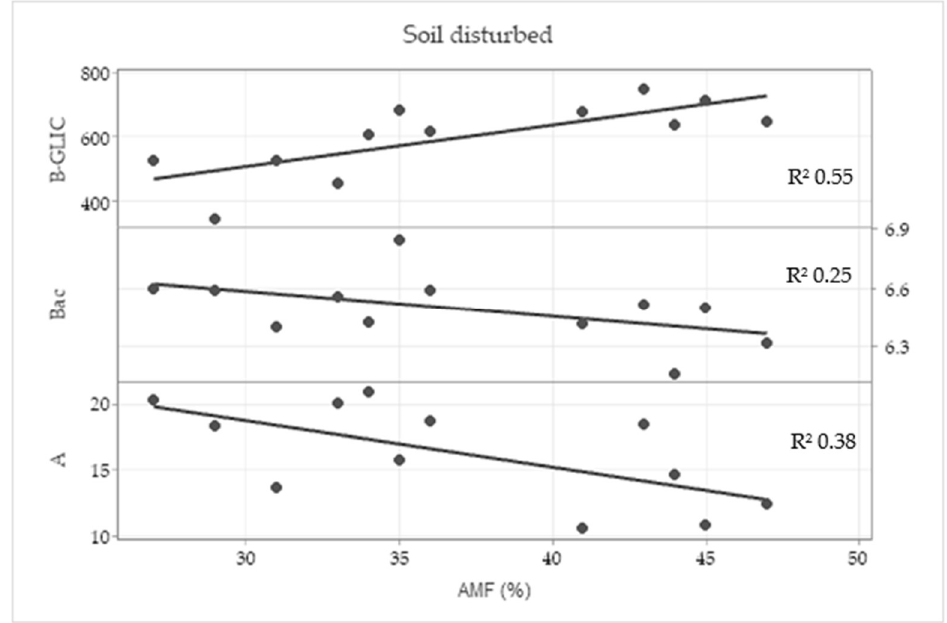
Figure 7. Linear regression analysis between wheat root colonization by arbuscular mycorrhizal fungi (AMF) and β -glucosidase activity (B-GLIC), total bacteria (Bac) and photosynthetic rate (A) in the disturbed treatment with the coefficient of linear regression (R 2